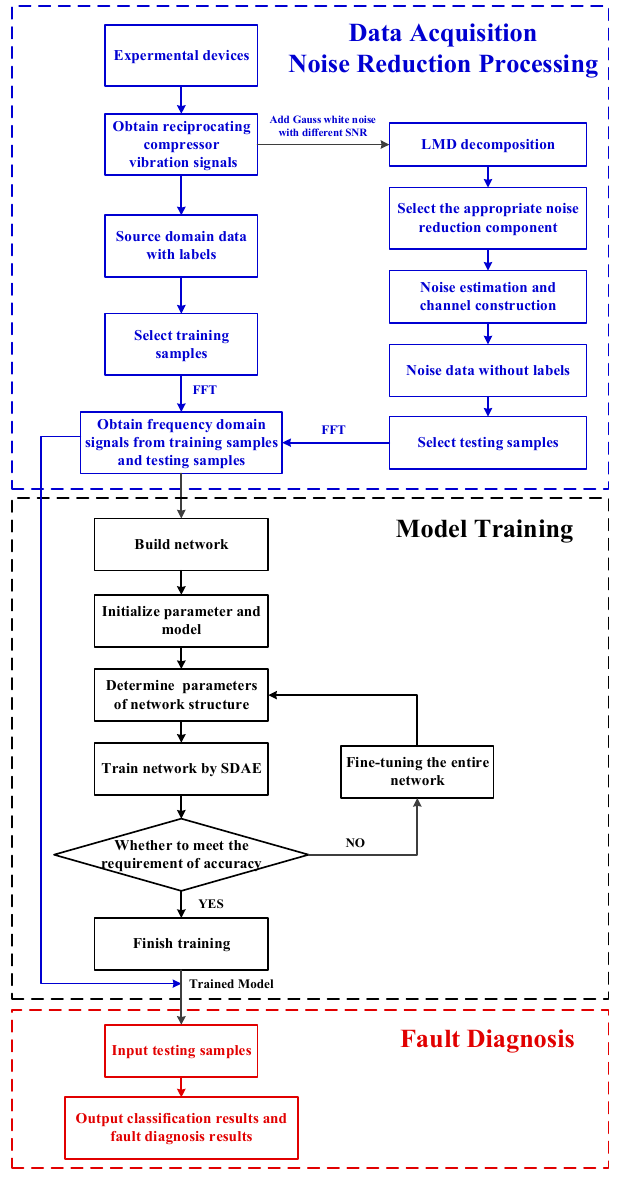
Figure 3. Flowchart of the proposed method.